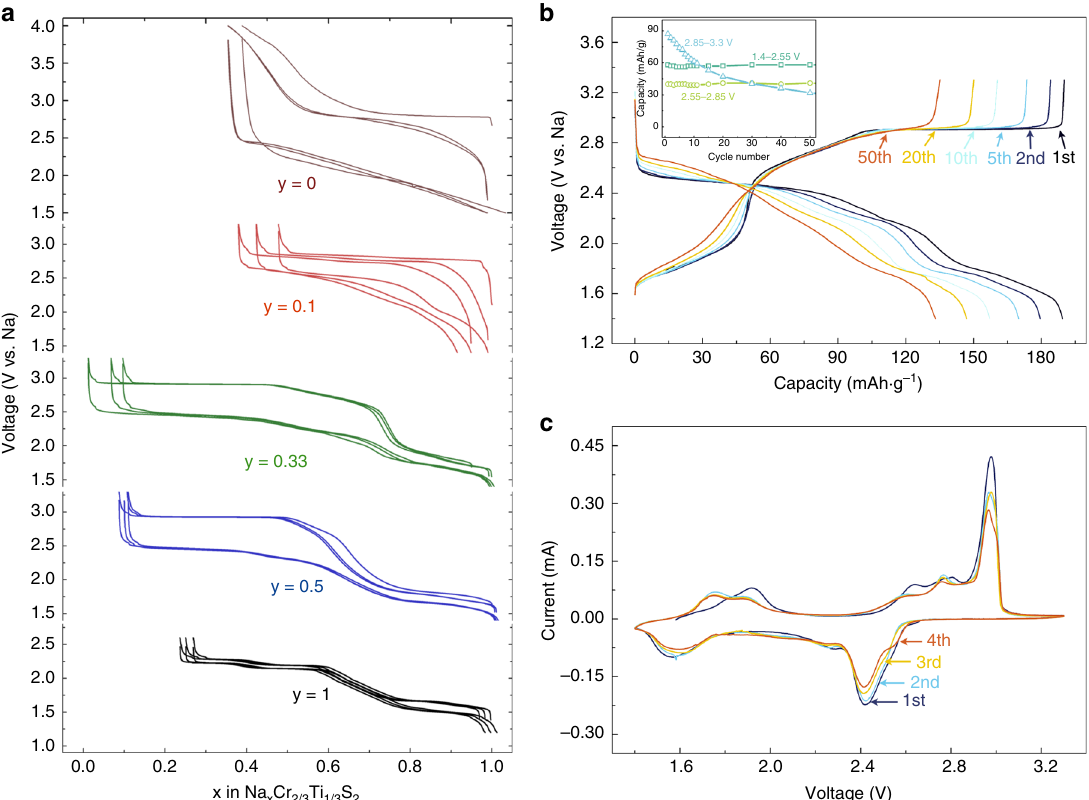
Fig. 1 Electrochemical performance of NaCr 1 − y Ti y S 2 series. a Voltage pro fi le for the NaCr 1 − y Ti y S 2 series versus Na + /Na at C/10 rate. The Coulombic ef fi ciency of NaCr 2/3 Ti 1/3 S 2 at the fi rst cycle is superior to 100% for there are few Na vacancies in the pristine material without Na precursor excess. b The voltage pro fi le over fi rst 50 cycles for a Na/NaCr 2/3 Ti 1/3 S 2 cell together with (as inset) its capacity retention in range of 1.4 – 2.55, 2.55 – 2.85 and 2.95 – 3.3 V at C/10 rate. c First four cyclic voltammograms for the NaCr 2/3 Ti 1/3 S 2 electrode cycled between 3.3 and 1.4